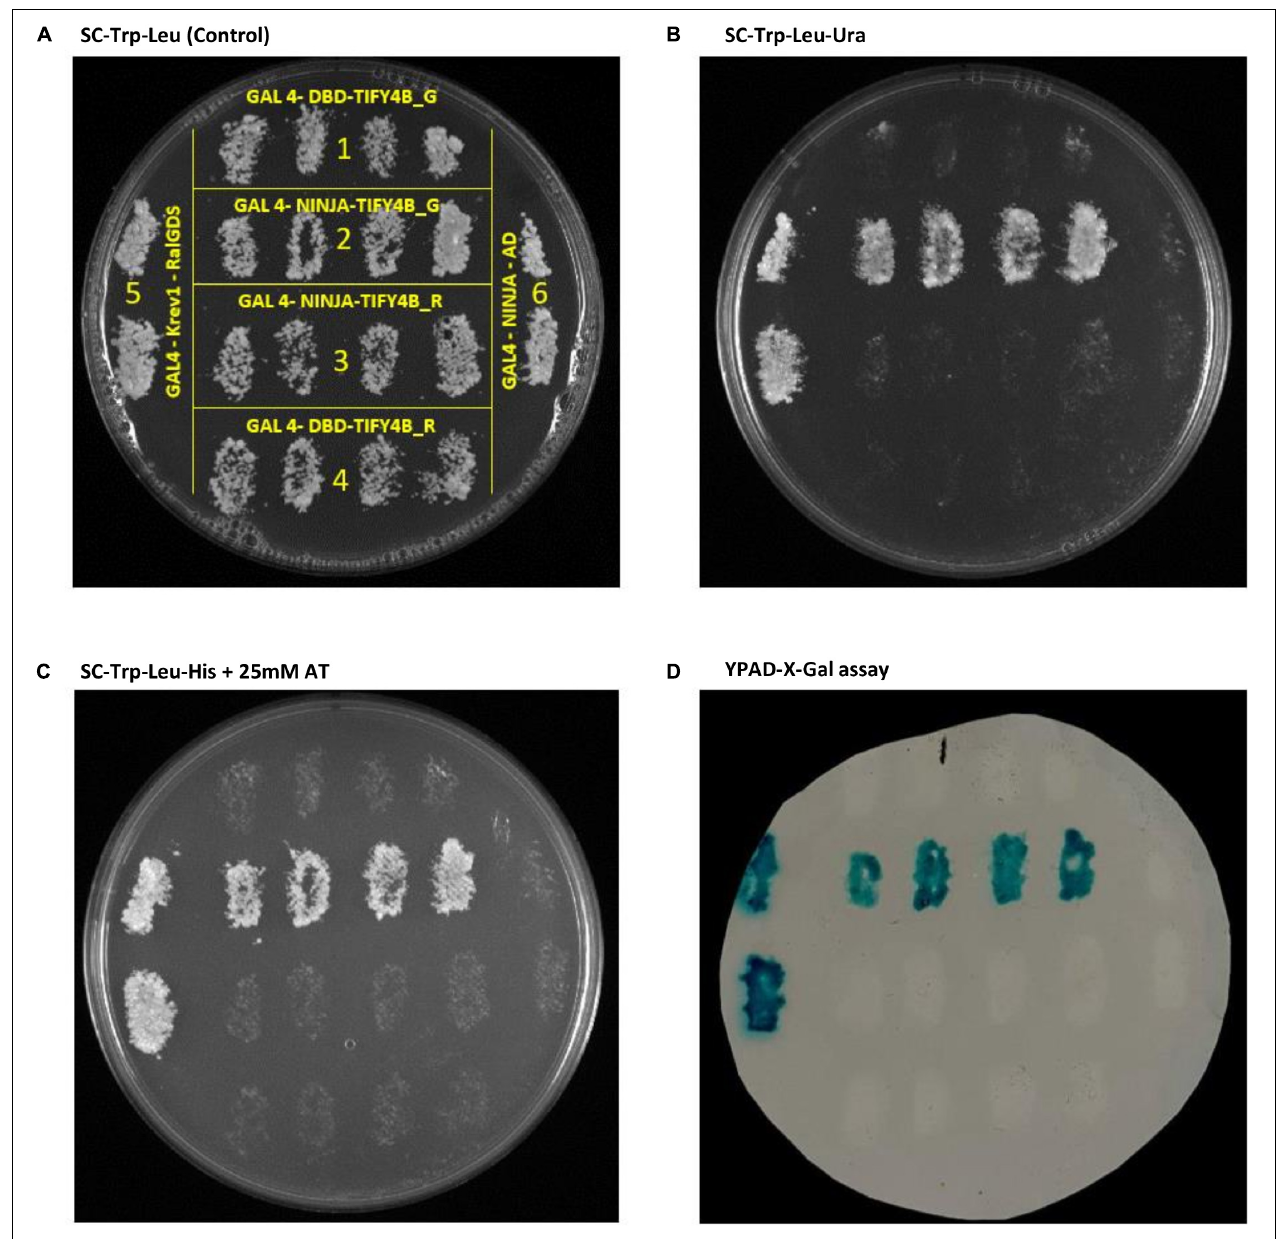
FIGURE 5 | Saccharomyces cerevisiae Y2H analysis of protein-protein interactions between CaNINJA and Rupali or Genesis836 alleles of CaTIFY4B. (A) Control plate. (B) Test for URA3 reporter gene activation. (C) Test for HIS3 reporter gene activation. (D) Test for lacZ reporter gene activation. Plates in panels (B–D) were replica plated from plate (A) ; growth on these plates indicates a positive protein-protein interaction. Each patch is derived from a single transformed colony; patches for 1, 4, and 6 are negative controls while 5 (GAL4-Krev1-RalGD) is a strong positive control. Details for each of the construct interactions are provided in Supplementary Table 1